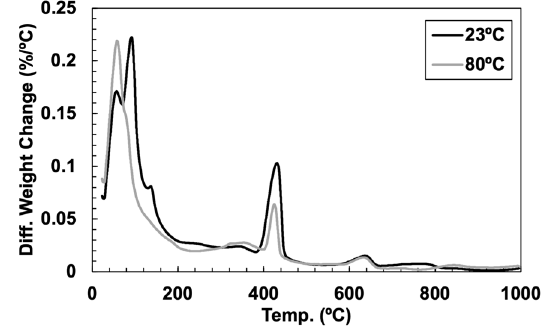
Figure A3. TGA results for FA mixture with different curing